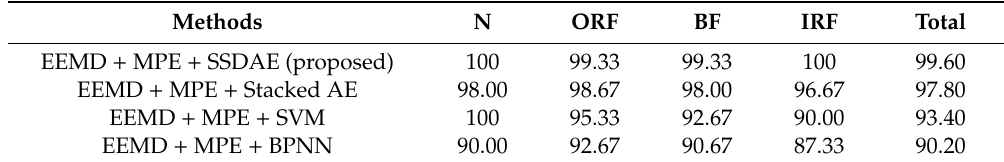
Table 4. Classification accuracy (%) using di ff erent classification models.